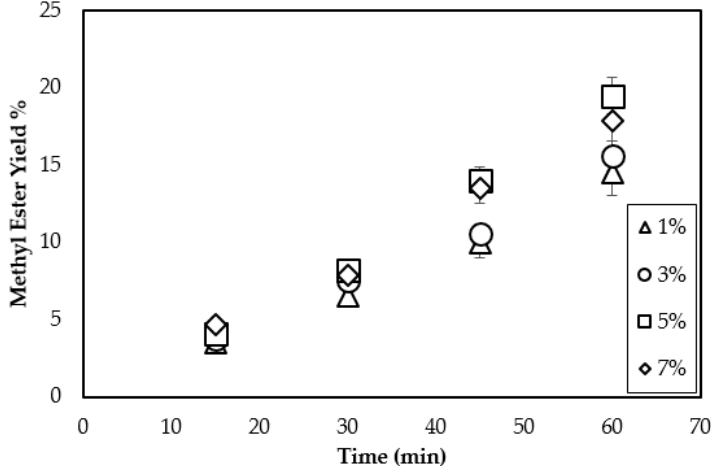
Figure 5. Effect of the catalyst loading on the methyl ester yield (90 ◦ C and a triolein flow rate of 6.0